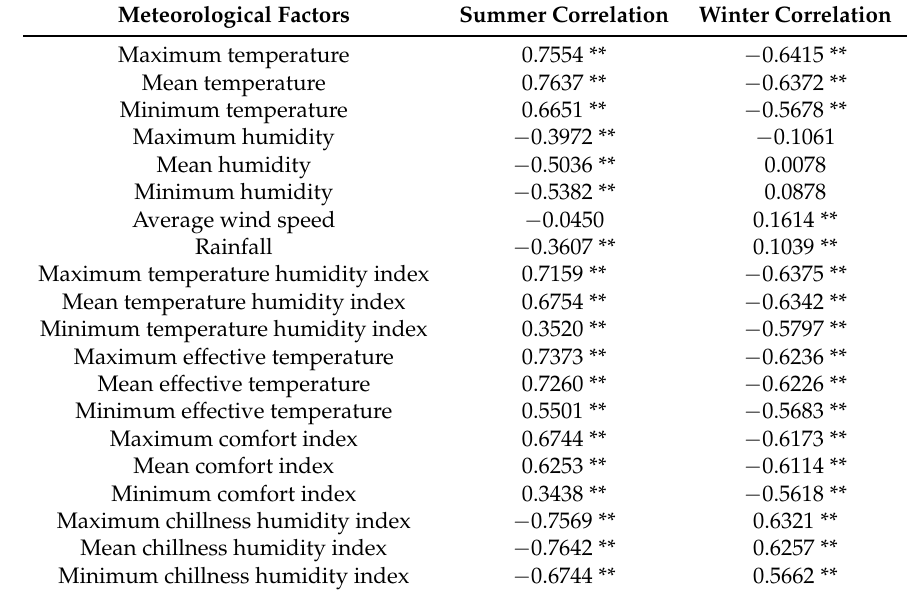
Table 1. Summer and winter holiday daily maximum load per-unit value and 20 meteorological factors of